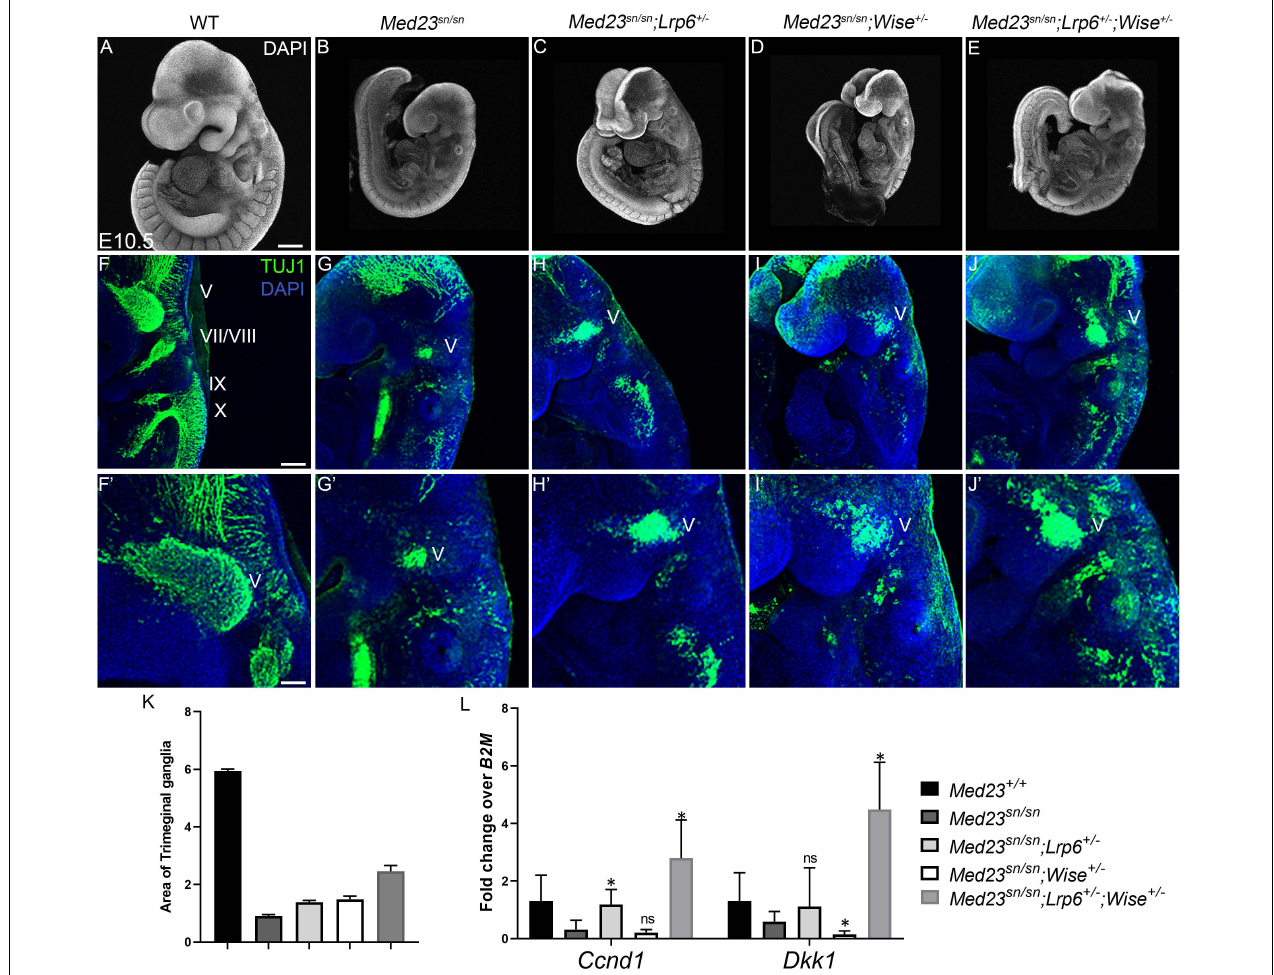
FIGURE 6 | Rescue of the Med23 sn / sn phenotype by modulating WNT signaling. DAPI stained E9.5 (A) wild-type, (B) Med23 sn / sn , (C) Med23 sn / sn ; Lrp6 + / − , (D) Med23 sn / sn ; Wise + / − and (E) Med23 sn / sn ; Lrp6 + / − ; Wise + / − embryos. TuJ1 immunostained (green) E9.5 (F) wild-type (G) Med23 sn / sn (H) Med23 sn / sn ; Lrp6 + / − , (I) Med23 sn / sn ; Wise + / − and (J) Med23 sn / sn ; Lrp6 + / − ; Wise + / − , embryos. Combinatorial loss of Lrp6 and Wise restores neuronal differentiation in the epibranchial region of Med23 sn / sn embryos. (F (cid:48) –J (cid:48) ) are higher magnification images of (F–J) focused on the trigeminal ganglia. (K) Quantification of the area of Tuj1 staining in the trigeminal ganglia is shown as a ratio of the length of the embryo for wild-type, Med23 sn / sn , Med23 sn / sn ; Lrp6 + / − , Med23 sn / sn ; Wise + / − and Med23 sn / sn ; Lrp6 + / − ; Wise + / − (L) qPCR analysis of cDNA obtained from E9.5 wild-type, Med23 sn / sn , Med23 sn / sn ; Lrp6 + / − , Med23 sn / sn ; Wise + / − , and Med23 sn / sn ; Lrp6 + / − ; Wise + / − embryos indicates a significant increase in Ccnd1 and Dkk1 transcripts in Med23 sn / sn ; Lrp6 + / − ; Wise + / − embryos compared to WT and Med23 sn / sn . Statistical analysis was performed using Students t -test with Med23 sn / sn as one of the nominal variables. Scale bars for (A–E) is 300 um, (F–J) is 200 um, (F (cid:48) –J (cid:48) ) is 50 um. * p <